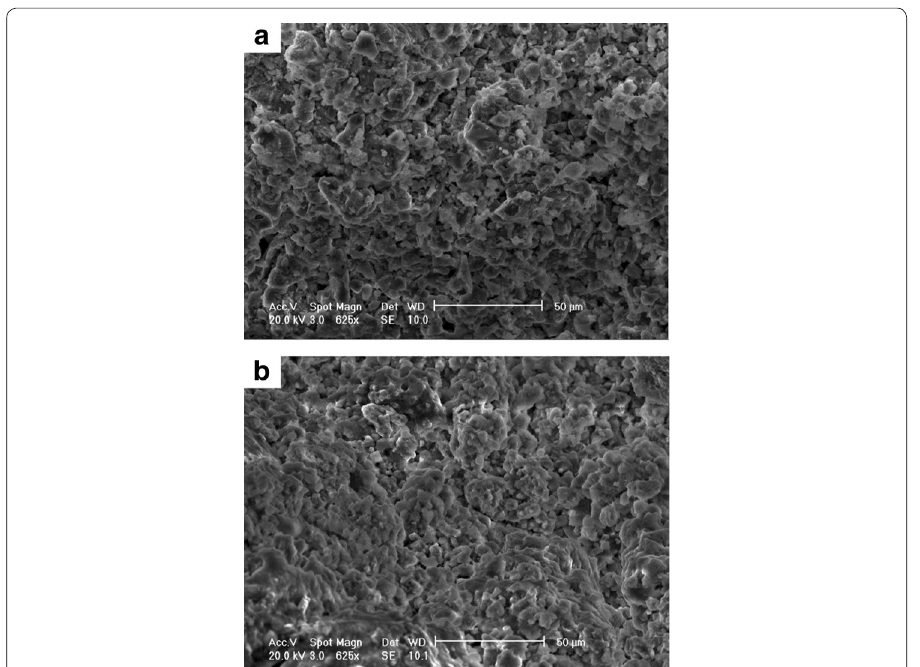
Table 3 Details of the oedometer tests Weathering degree Sample